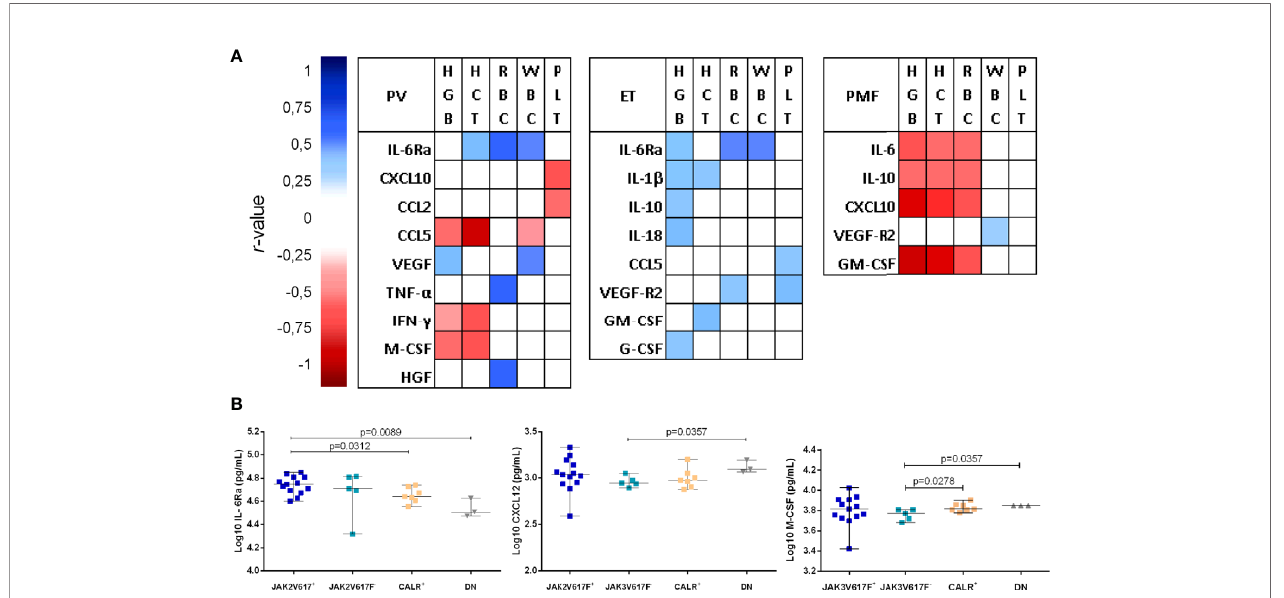
FIGURE 3 | (A) Correlation between soluble mediator levels and laboratory parameters of healthy subjects (CTRL, n = 17) and patients with essential thrombocythemia (ET, n = 28), polycythemia vera (PV, n = 19), and primary myelo fi brosis (PMF, n = 16). The Spearman coef fi cient ( r -value) was represented by a color gradient that ranged from close to 1 (dark blue) to − 1 (dark red); white indicates no correlation. The correlations depicted in this fi gure were signi fi cant when p <0.05. HCT, hematocrit; HGB, hemoglobin concentration; PLT, platelet count; RBC, red blood cell count; WBC, white blood cell count. (B) Association between driver mutation status and IL-6Ra, CXCL12, and M-CSF levels in bone marrow plasma from patients with ET. JAK2V617 + (n = 13 ET patients positive for JAK2V617F mutation). JAK2V617F - (n = 5; ET patients negative for JAK2V617F mutation). CALR + (n = 7; patients positive for calreticulin mutation). DN (n = 3; double negative for CALR and JAK2V617 patients). Statistical difference when p <0.05, Mann – Whitney